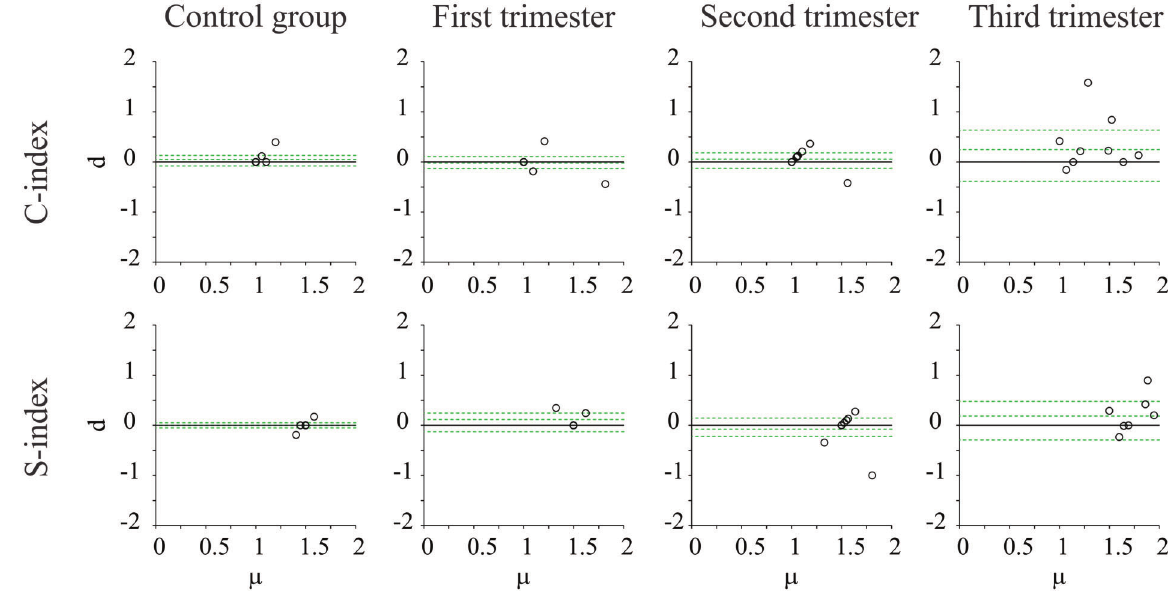
Braz J Med Biol Res | doi: